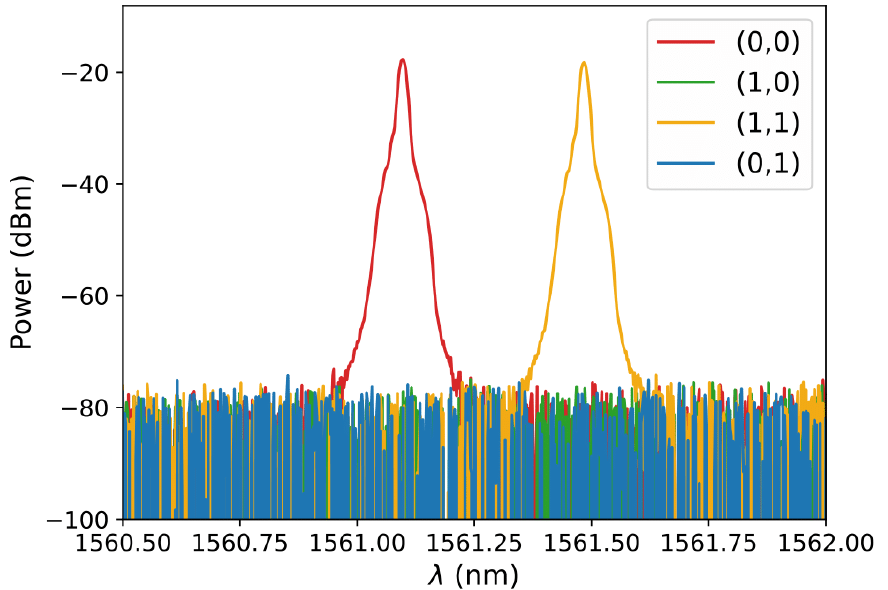
Figure 2. Optical spectrum of the four states of the UFL-KDS.